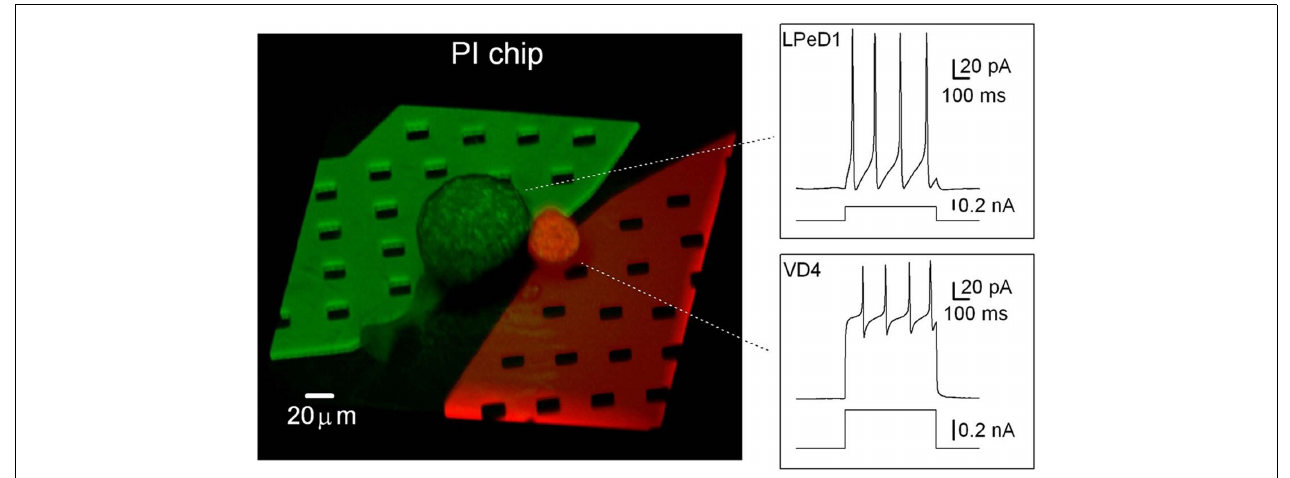
with a recording solution containingTexas-red (red). Insets show the simultaneous recording of the voltage responses to current injections for a VD4 and an LPeD1 neuron plated on the same PI chip. From Martina et al. (2011).